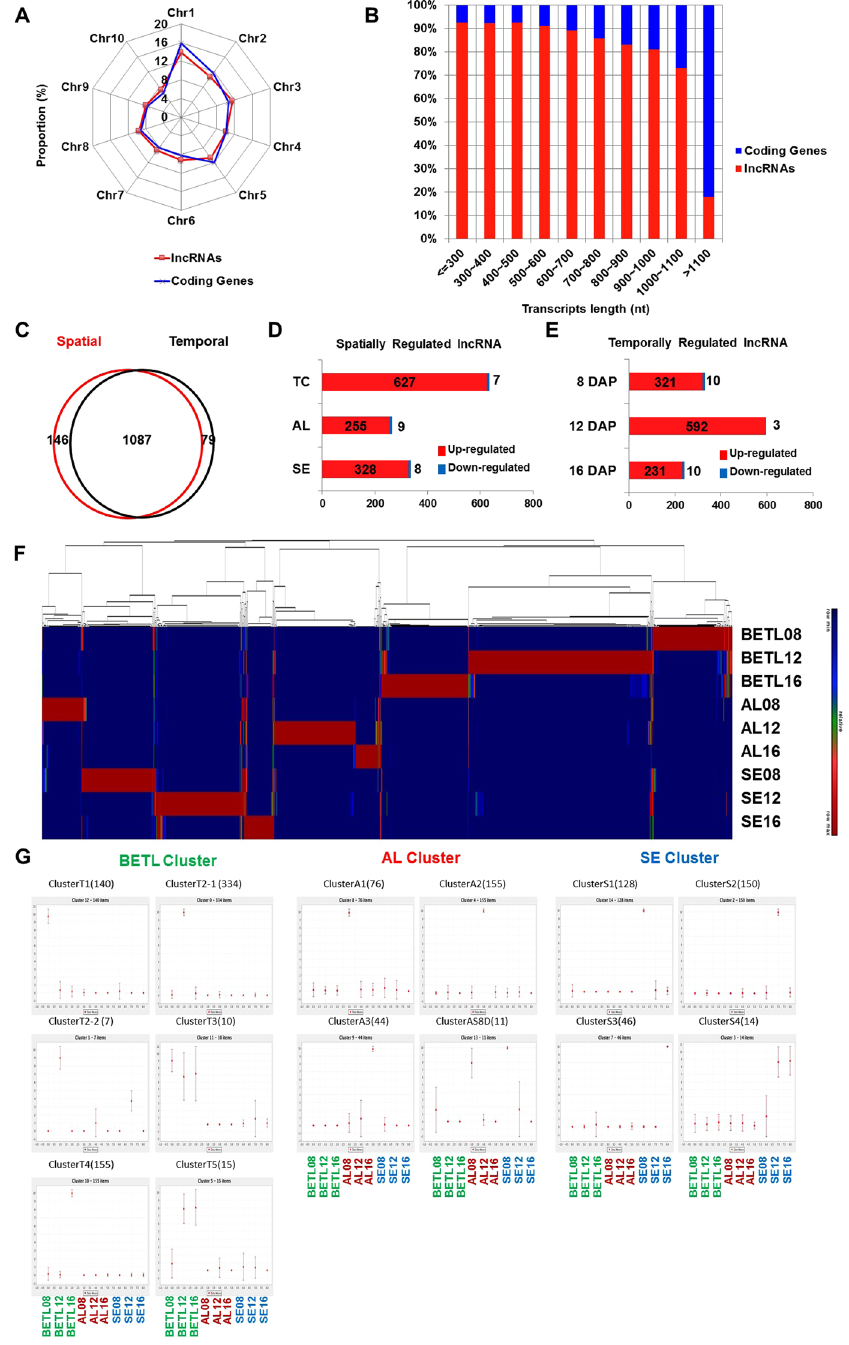
Figure 3. Identification of long noncoding RNAs in the maize endosperm. ( A ) Distribution of lncRNAs along each chromosome. The proportion of coding transcripts and lncRNAs for each chromosome. ( B ) Size distributions of lncRNAs and coding transcripts. ( C ) Venn diagram of the number of spatially and/or temporally regulated lncRNAs with FPKM > 0.01 and more than 4-fold expression-level changes. (D) The numbers of lncRNAs up- or down-regulated more than 4-fold in any tissue are shown. (E) The numbers of lncRNAs up- or down-regulated more than 4 fold at any DAP are shown. (F) Hierarchical cluster analysis of spatio-temporally regulated lncRNAs. (G) SOM clusters depicted based on clustering patterns. In parentheses are the number of co-expressed transcription factors and the number of genes that belong to each SOM cluster. The relative level of transcript is plotted on the y axis for each of nine samples: BETL08, BETL12, BETL16, AL08, AL12, AL16, SE08, SE12, and SE16 from left to